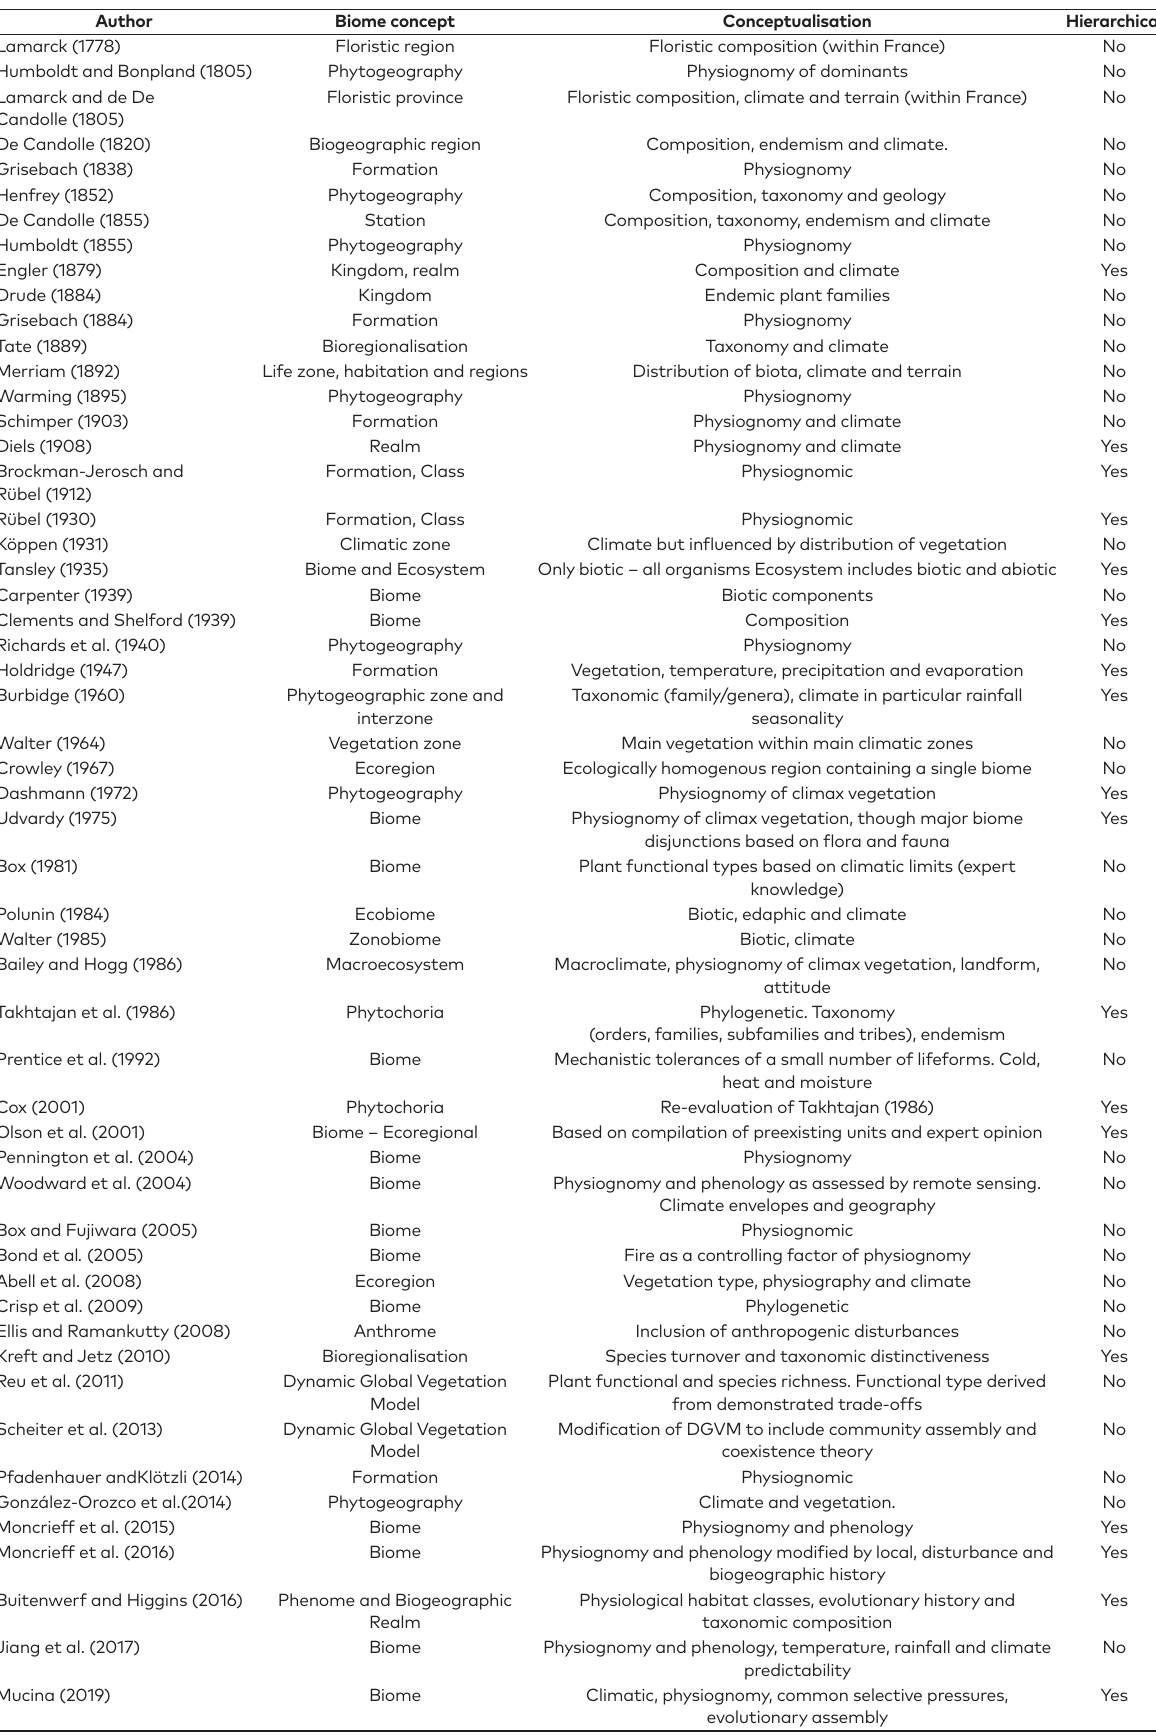
Table 1. Historical development of vegetation-based biome and biome-like